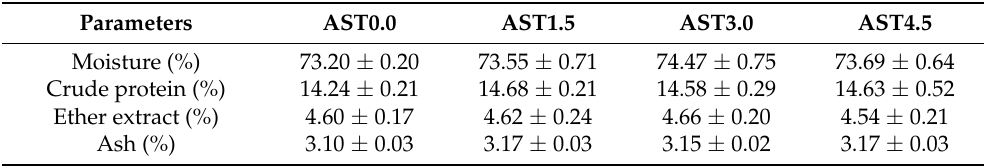
Figure 1. Growth performance including weight gain (WG) ( A ) and specific growth rate (SGR) ( B ) and feed utilization including feed intake (FI) ( C ) and feed conversion ratio (FCR) ( D ) of P. hypophthalmus fed diets with different AME inclusion levels. Data lines denote best fit models for the data. Equations and R square in the figures demonstrates the relationship between the measured parameters and AME inclusion levels. Individual marker indicates the number of technical replicates (n = 3). Table 3. Whole body composition analysis of striped catfish juveniles fed diets supplemented with AME inclusion of levels after 2 months feeding